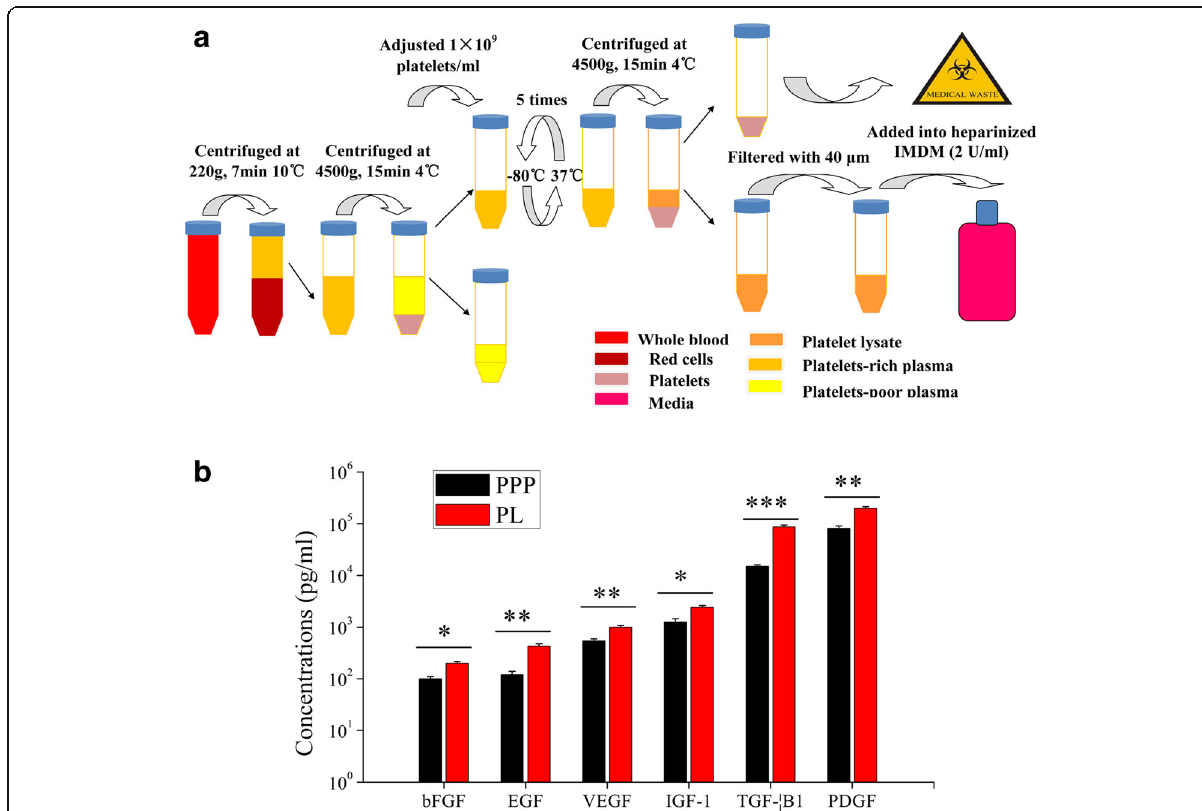
Fig. 1 Platelet lysis released sufficient amounts of growth factors in PL. a Schematic overview of preparation of PL. PRP was generated from peripheral blood through a series of centrifugations. Based on platelet counts (10 9 platelets/ml) after the centrifugation step, sufficient PPP was removed to achieve PRP. PL was prepared from PRP by a simple freeze-thawing procedure. b The quantification of growth factors in PL and PPP was determined using ELISA. Bars represented means ± SD. n = 5; * p < 0.05, ** p < 0.01, and *** p <